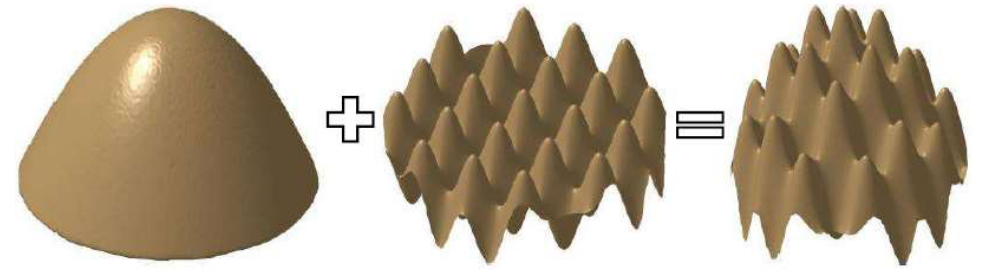
Figure 1. Illustration of compound freeform surface combination theory.